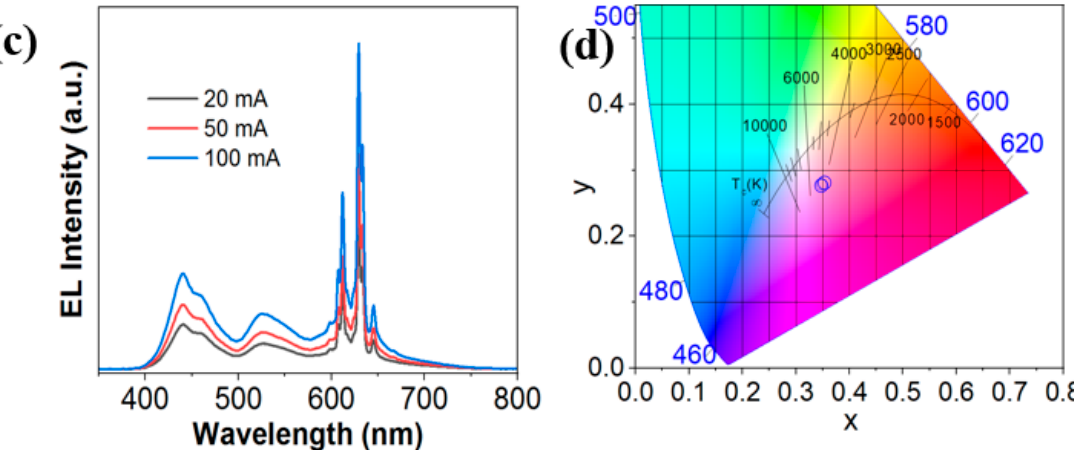
Figure 6. ( a ) Electroluminescence spectrum of the nanowire WLED without nanosheet KTFM red phosphor. The inset is the optical image of white-light emission from the nanowire WLED. ( b ) Electroluminescence spectrum of the nanowire pc-WLED showing clear red emission from the KTFM nanosheets. The inserted pictures show bright warm-white light emissions of the nanowire pc-WLEDs. ( c ) Electroluminescence spectra of the nanowire pc-WLED under injection current